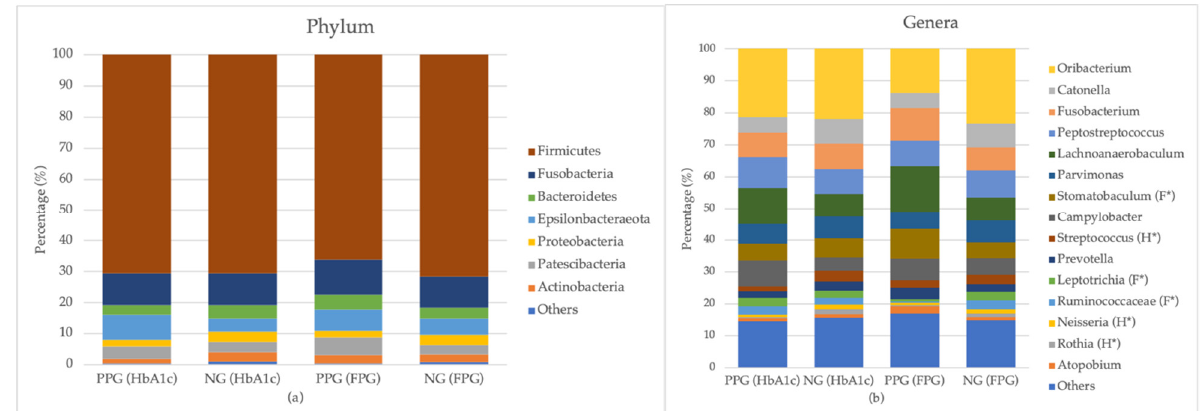
Figure 3. Bar plots of taxonomic profiles of patients in PPG and NG groups at the phylum level ( a ) and the genus level ( b ). Left to right bars in each panel shows the relative abundances of PPG HbA1c , NG HbA1c , PPG FPG , and NG FPG , respectively. Phyla and genera with the relative abundance below 1% are not directly shown in the figure, but included in others. H * and F * in parentheses of the right panel indicate the genus with significant difference (independent t -test with p < 0.05) between two groups (PPG and NG) in cases of using the HbA1c and FPG levels as criteria, respectively.